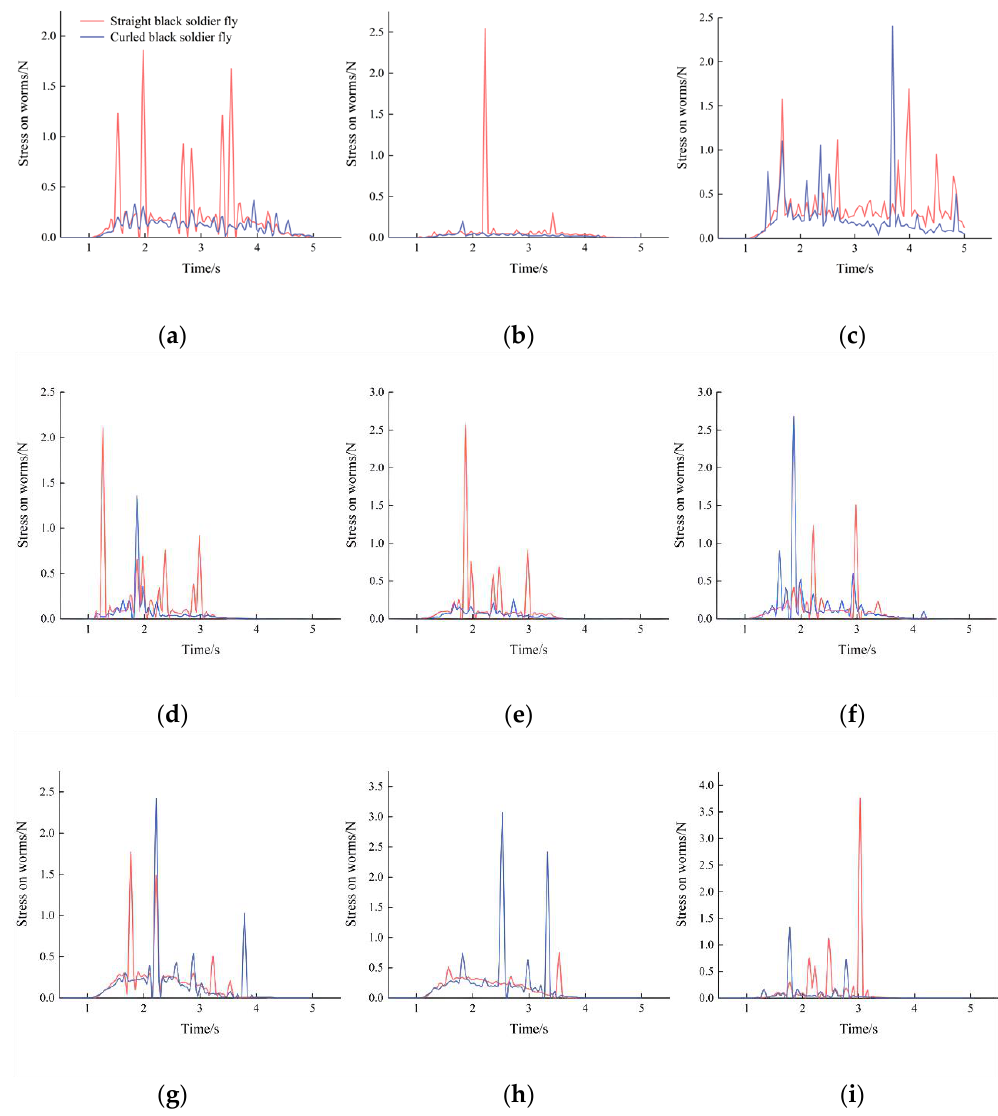
Figure 16. Force analysis in the separation movement of black soldier fly. ( a ) X 1 = 0.011 m, X 3 = 0.005 m. ( b ) X 1 = 0.011 m, X 3 = 0.006 m. ( c ) X 1 = 0.011 m, X 3 = 0.007 m. ( d ) X 1 = 0.012 m, X 3 = 0.005 m. ( e ) X 1